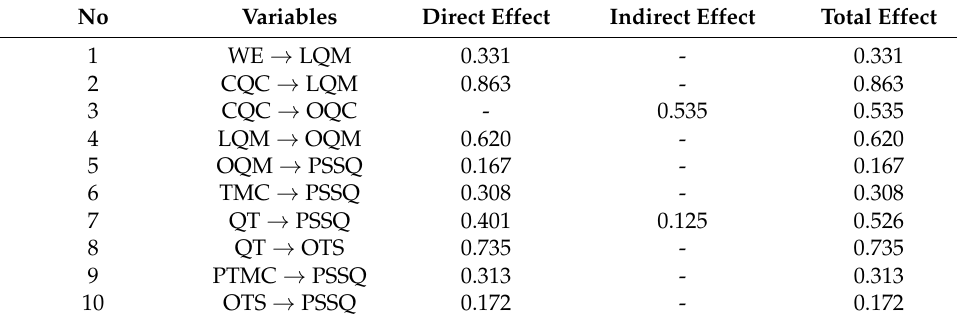
Figure 2. The initial SEM for evaluating factors affecting perceived superior shoe quality in the shoe manufacturing industry. Table 4. Direct effect, indirect effect, and total effect.